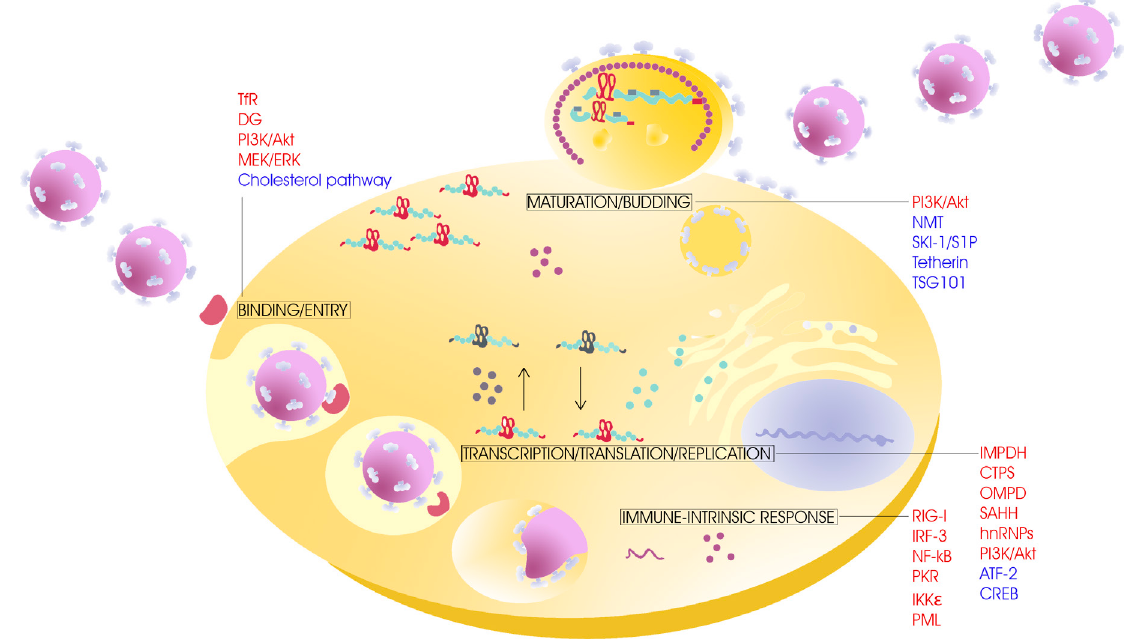
Figure 1. Main host factors involved in arenavirus multiplication analyzed as potential antiviral targets. In an infected cell the cellular factors discussed in this article (IMPDH: inosine monophosphate dehydrogenase; CTPS: cytosine triphosphate synthetase; SAHH: S-adenosylhomocysteine hydrolase; OMPD: orotidylic acid decarboxylase; hnRNPs: heterogeneous nuclear ribonucleoproteins; PI3K/Akt: phosphatidylinositol-3-kinase/protein kinase B; MEK/ERK:mitogen-activated protein kinase/extracellular signal-regulated kinase; IRF-3: interferon regulatory factor 3; IKKε : inhibitor of nuclear factor kB kinase–related kinase; NF- κ B: nuclear factor kappa B; RIG-I: retinoic acid-inducible gene I protein; PKR: protein kinase R; PML: promyelocytic leukemia protein; DG: dystroglycan; TfR: transferrin receptor) are indicated in red; other factors not discussed here (TSG101: tumor supresor gene 101; NMT: N -myristoyltransferase; SKI-1/S1P: subtilisin kexin isozyme-1/site 1 proprotein convertase; ATF-2: activating transcription factor 2; CREB: cAMP response element-binding [30–33] are in